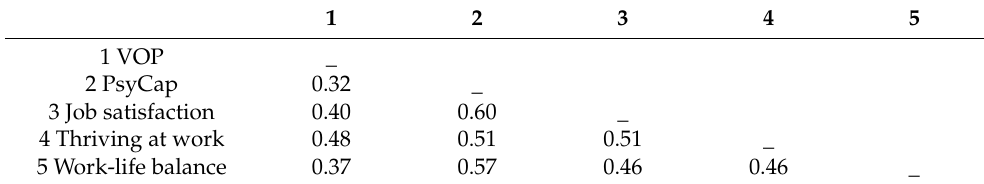
Table 2. Correlations for the study